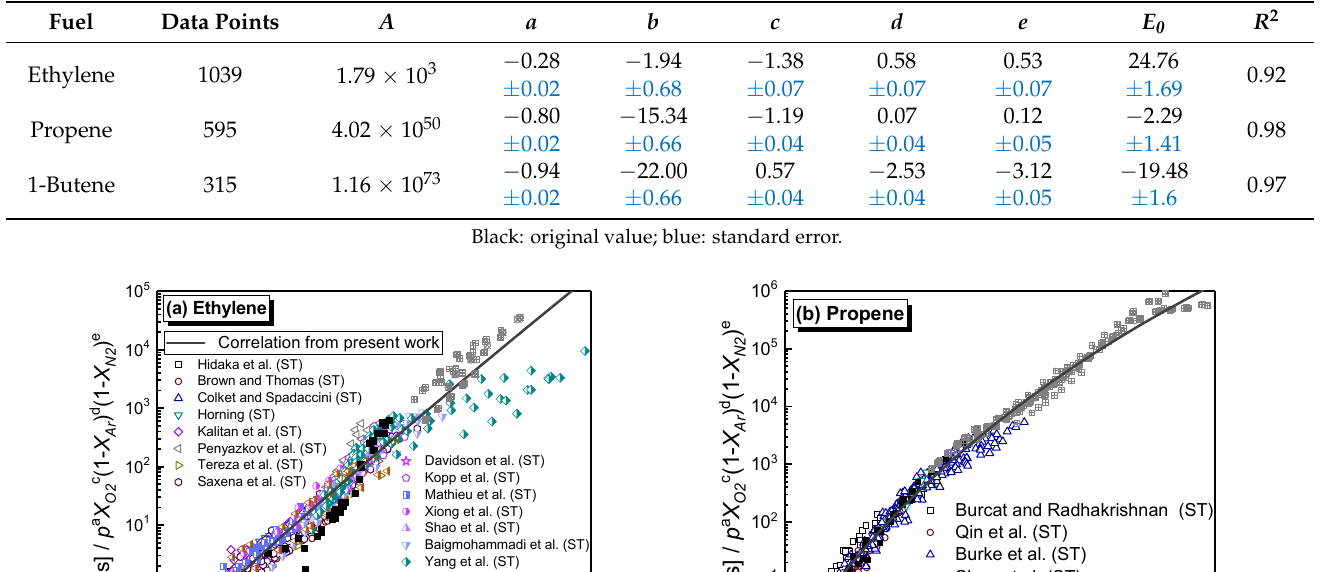
Table 4. Evaluated coefficients of Arrhenius correlation for C 2 -C 4 1-alkenes.